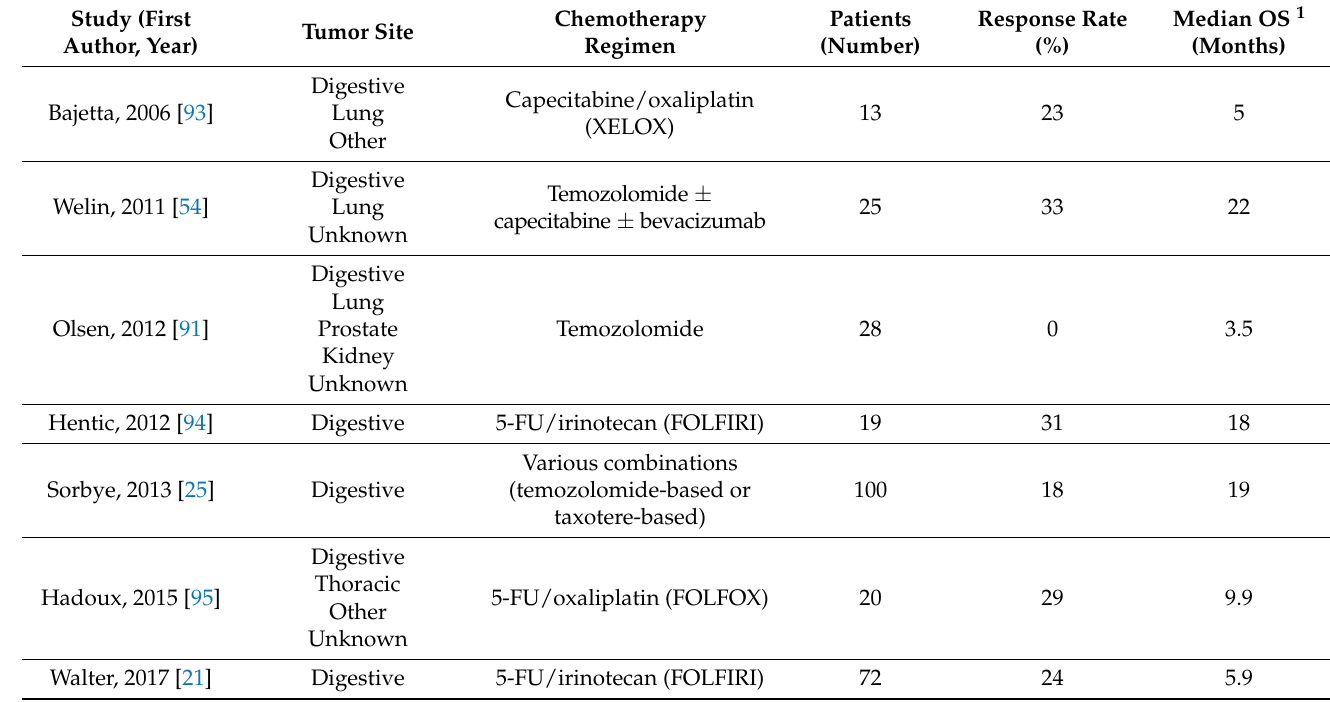
Table 3. Results of studies evaluating second-line chemotherapy in metastatic neuroendocrine carcinomas (NEC). Study